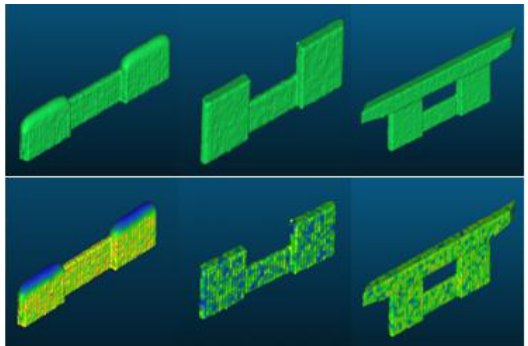
Table 2. The numerical results and construction progress in percentage for Pier